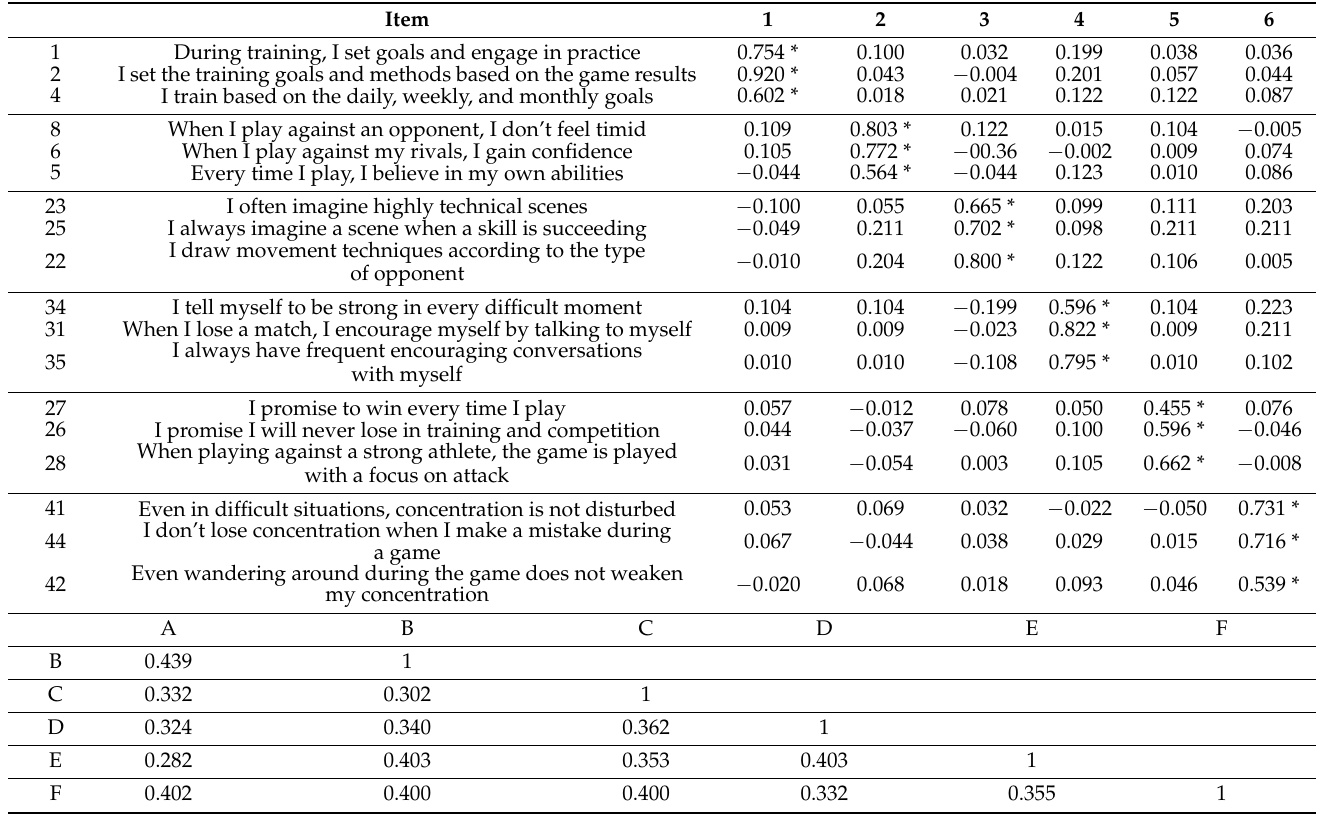
Table 12. Results of ESEM